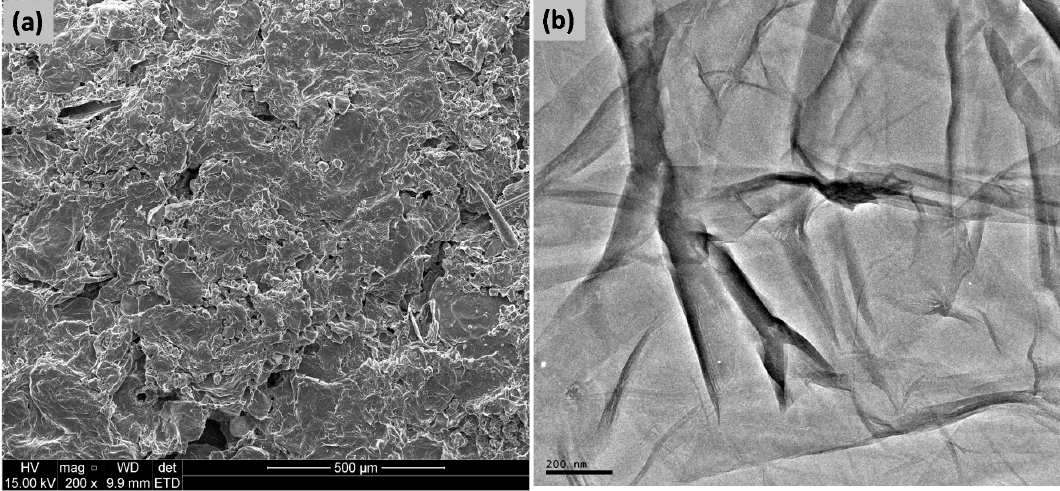
Figure 2. ( a ) SEM and ( b ) TEM micrographs of rGO.